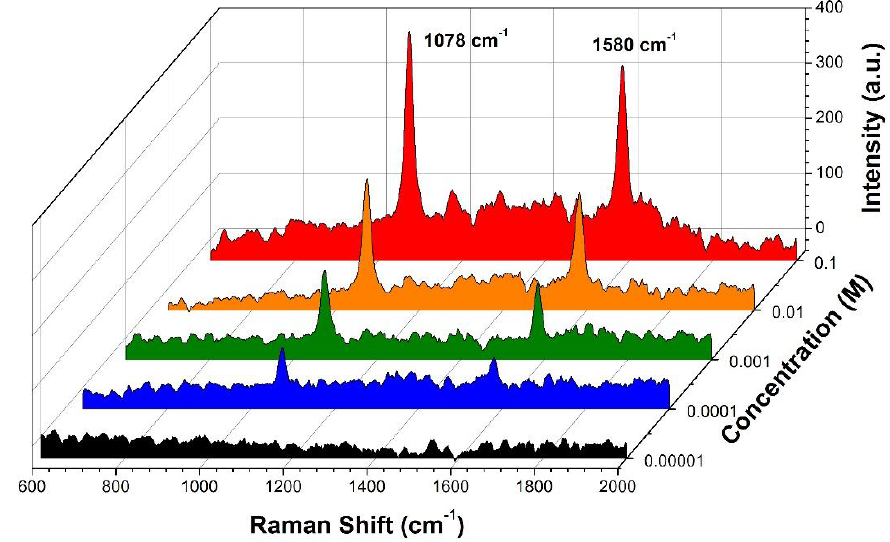
Figure 5. Raman intensities of the dried groove channel after the flowing of the pMBA ethanol solutions.